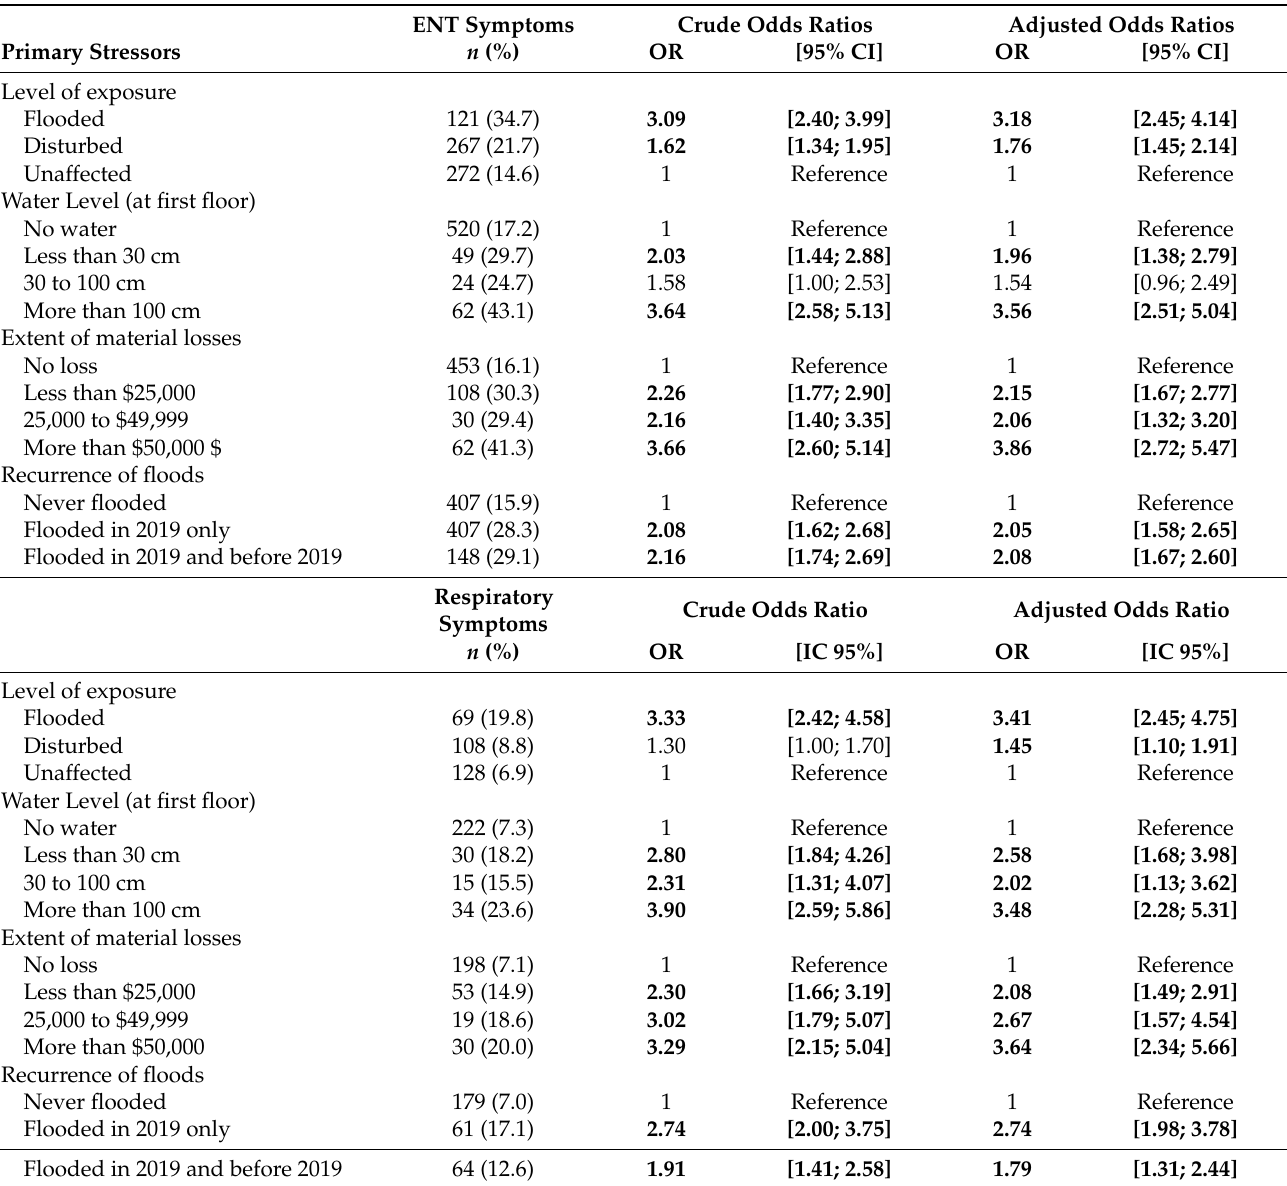
Table 5. Associations between primary stressors and ENT and respiratory symptoms in all regions affected by flooding according to sex, age, education and smoking status.